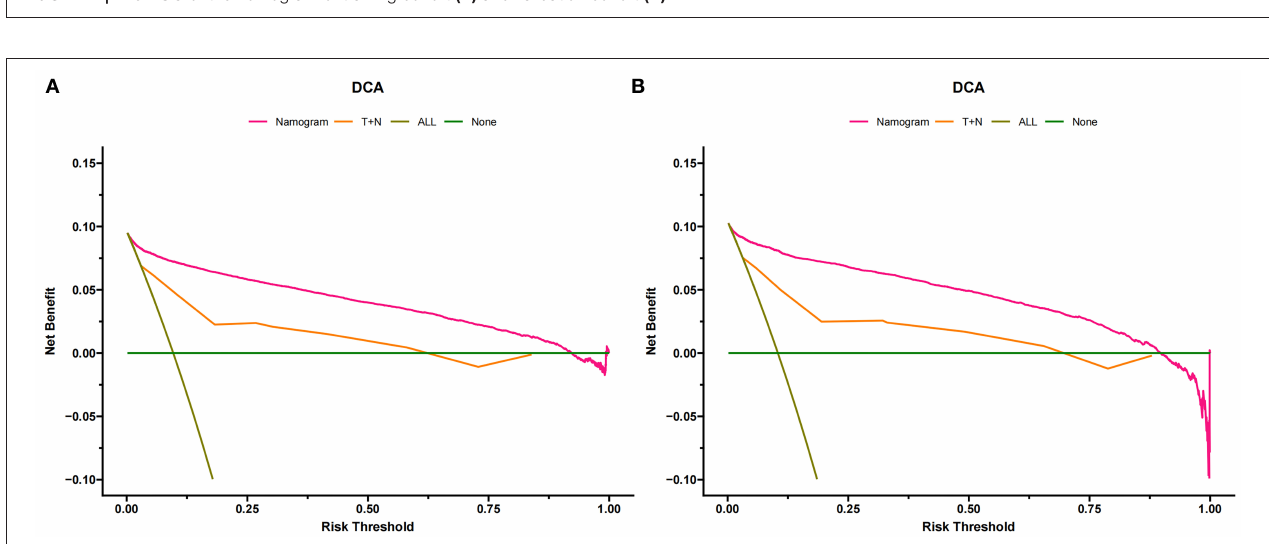
FIGURE 4 | The ROC of the nomogram of training cohort (A) and validation cohort (B) .